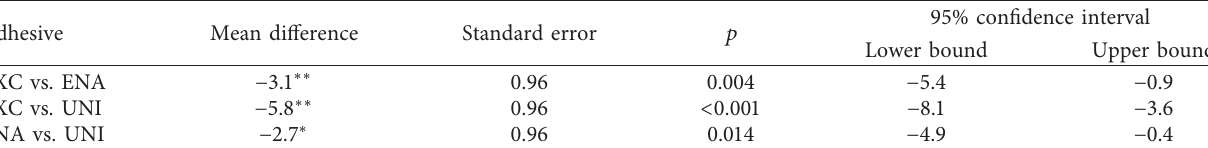
Table 4: Tukey’s honestly significant difference post hoc test for the effect of adhesive on microtensile